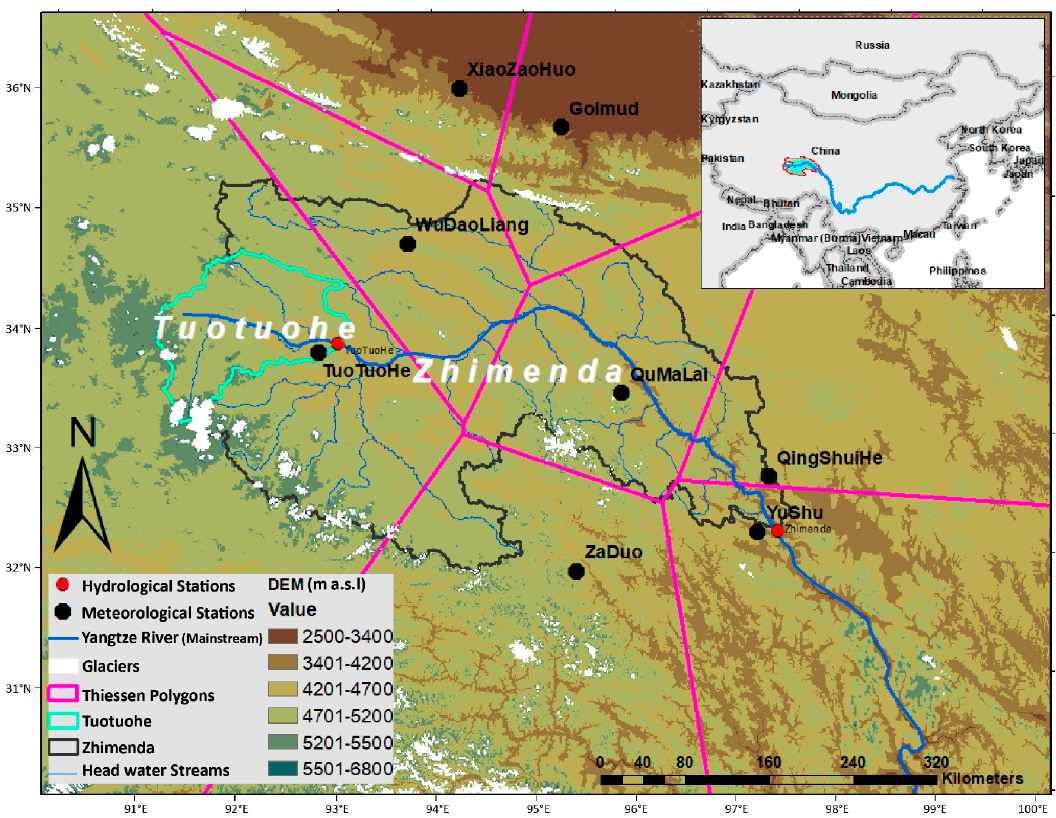
Figure 1. Study area of the headwaters of the Yangtze River (HWYZ) with hydrological and meteorological stations.